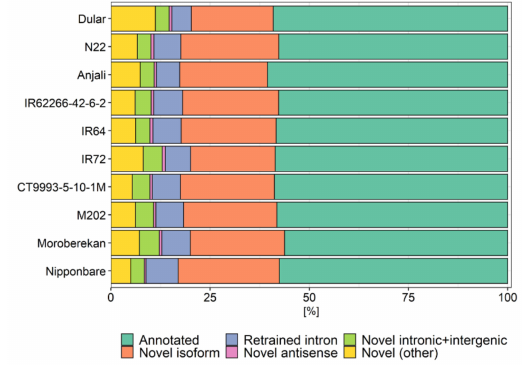
Figure A3. Annotated and novel transcripts as identified by g ff compare using the Nipponbare reference annotation. Cultivars were sorted alphabetically within the subspecies aus , indica and japonica